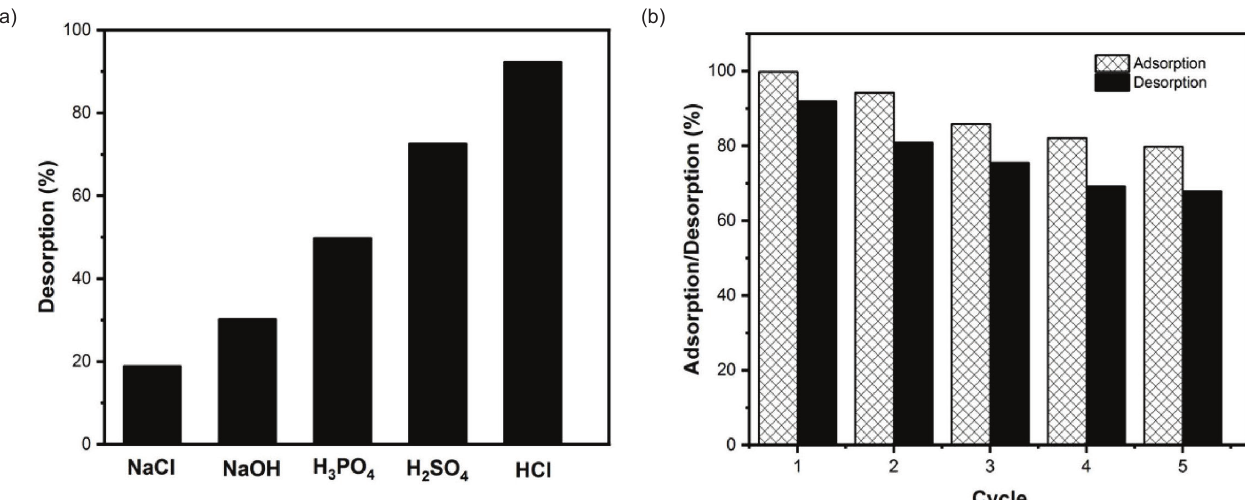
Fig. 8 – (a) Desorption of SR 3BL dye from Oxalis using various eluents; (b) adsorption/desorption cycles of SR 3BL dye using HCl (0.1 N) (Adsorption: dosage 1 g L –1 , pH 6, contact time 35 min. Desorption: eluent volume 50 mL, dosage 2 g L -1 , contact time 60 min. Temperature 25